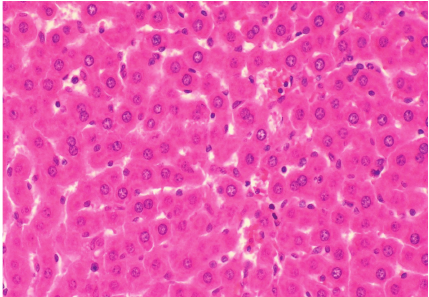
Figure 12: Histopathologic sections of liver (HE, x200), B: emodin group. The liver of emodin group showed few inflammatory cells infiltration in portal area and there were no obvious changes in hep- atic cells.